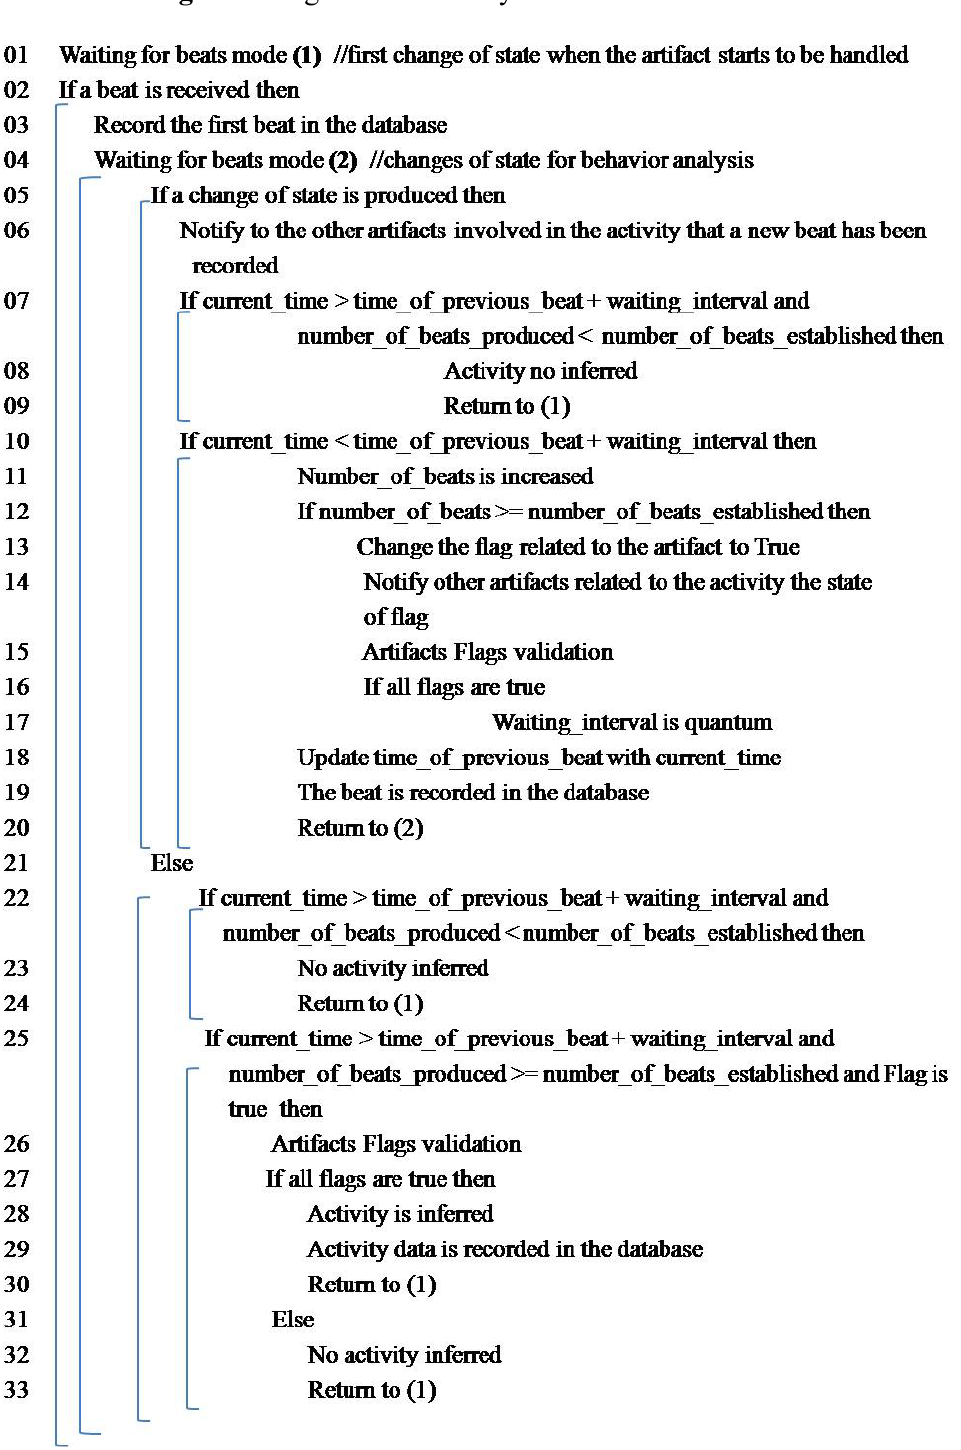
Figure 4. Algorithm for analysis of artifact